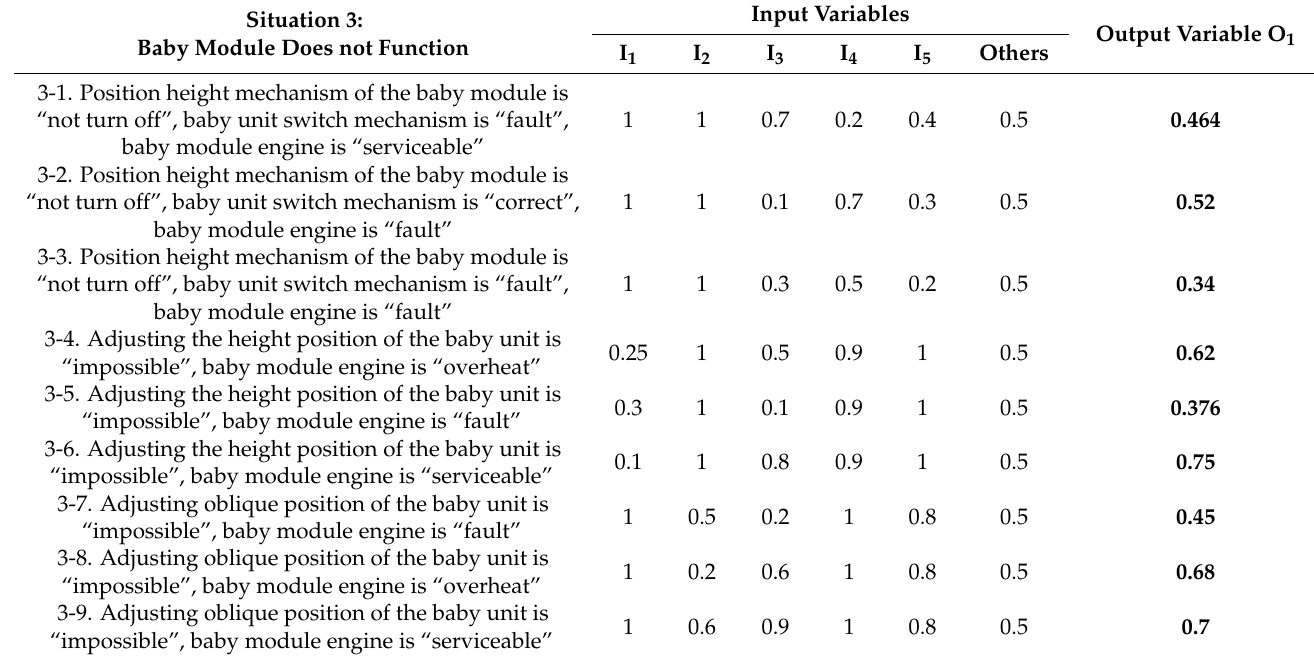
Table 6. Modeling results on Situation